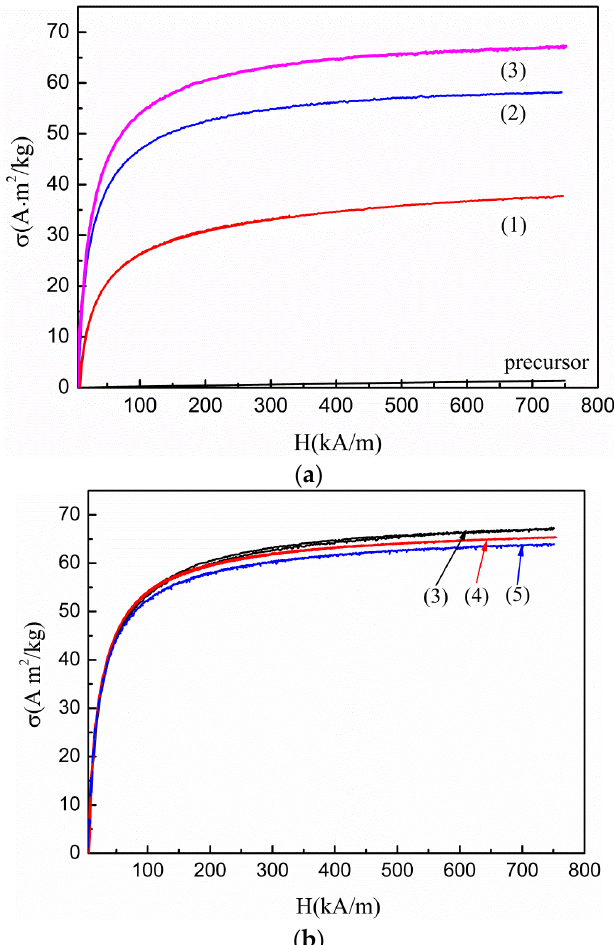
Figure 1. Specific magnetization curves of the precursor and as ‐ prepared samples (1)–(3) ( a ), and as ‐ prepared samples (3)–(5) ( b ).